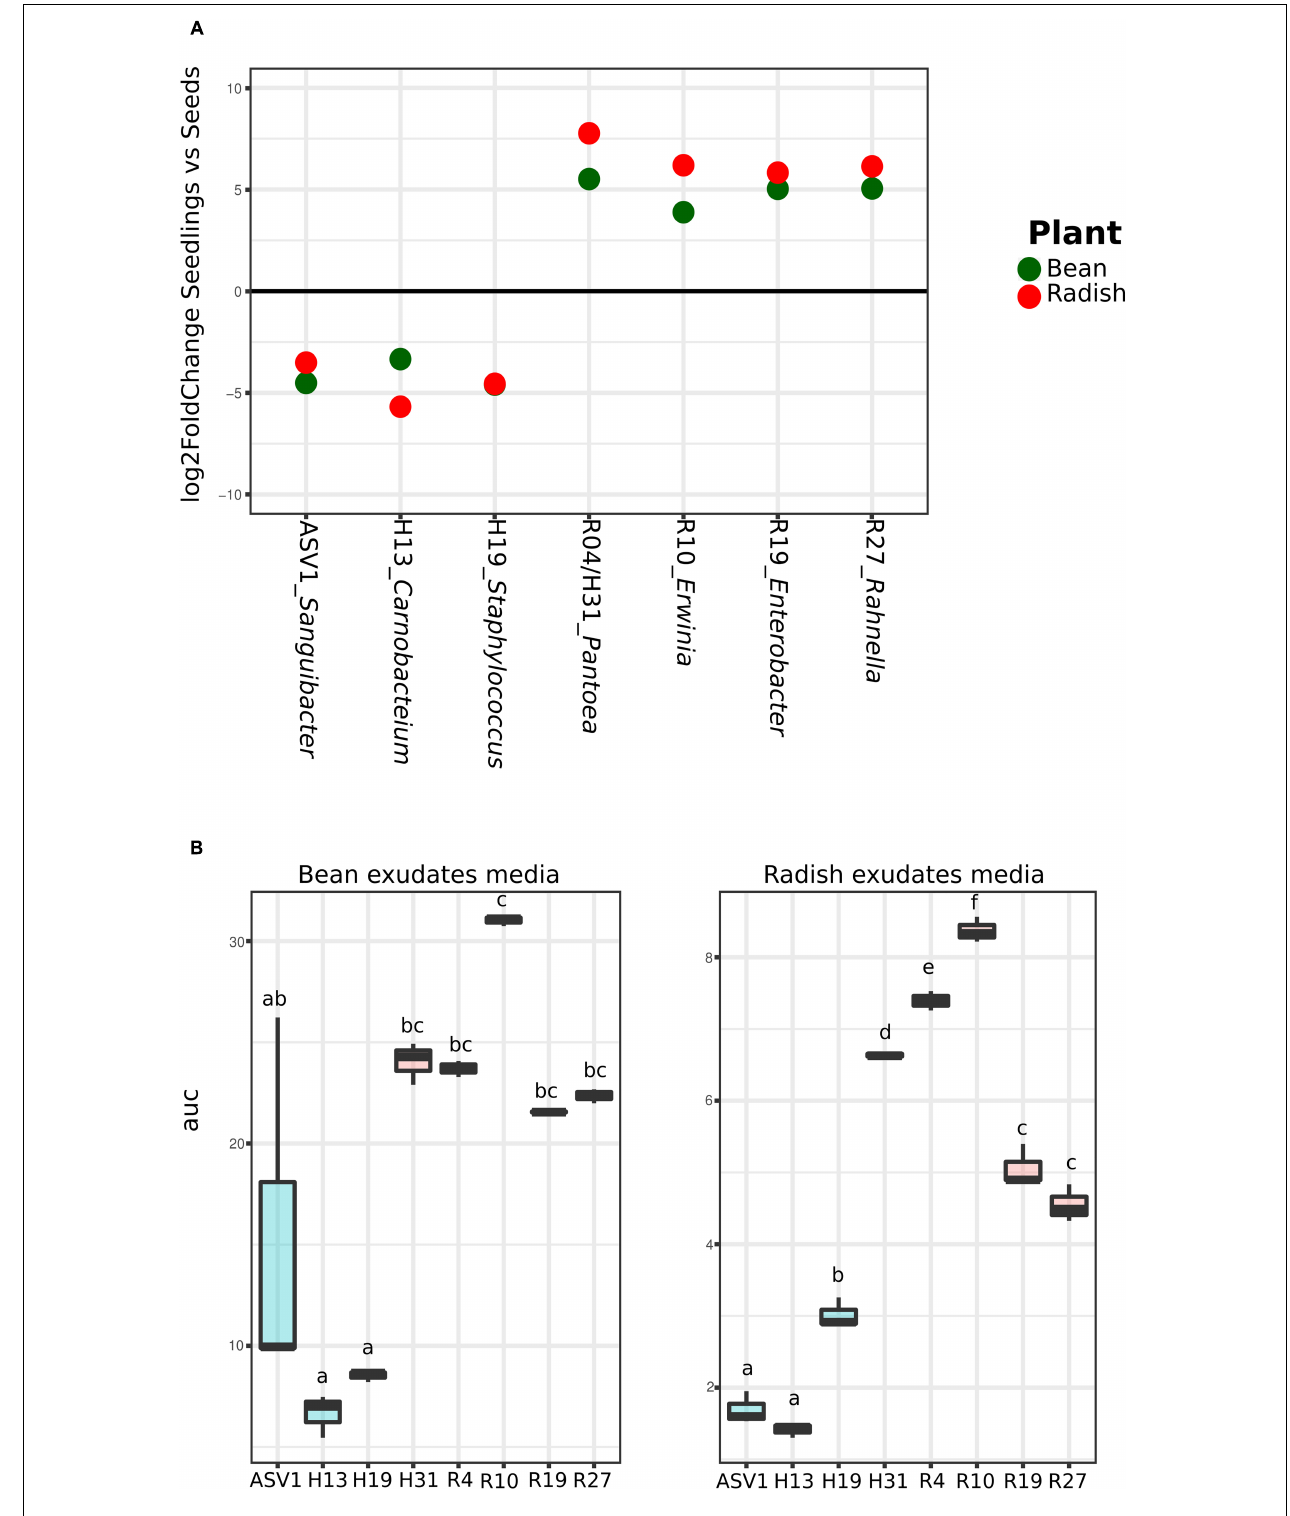
FIGURE 4 | Quantification of seed-associated bacteria potential growth on bean and radish seed exudates. (A) Metagenomics reads relative abundance Log2fold change in seedlings in comparison to seeds of the nine selected taxa according to DeSeq2. (B) Area under the growth curve (optical density [OD] in time) as a marker of the potential growth of the different bacteria strains. Letters indicate differences between individual means assessed with one factor ANOVA with post hoc Tukey HSD ( P < 0.05).